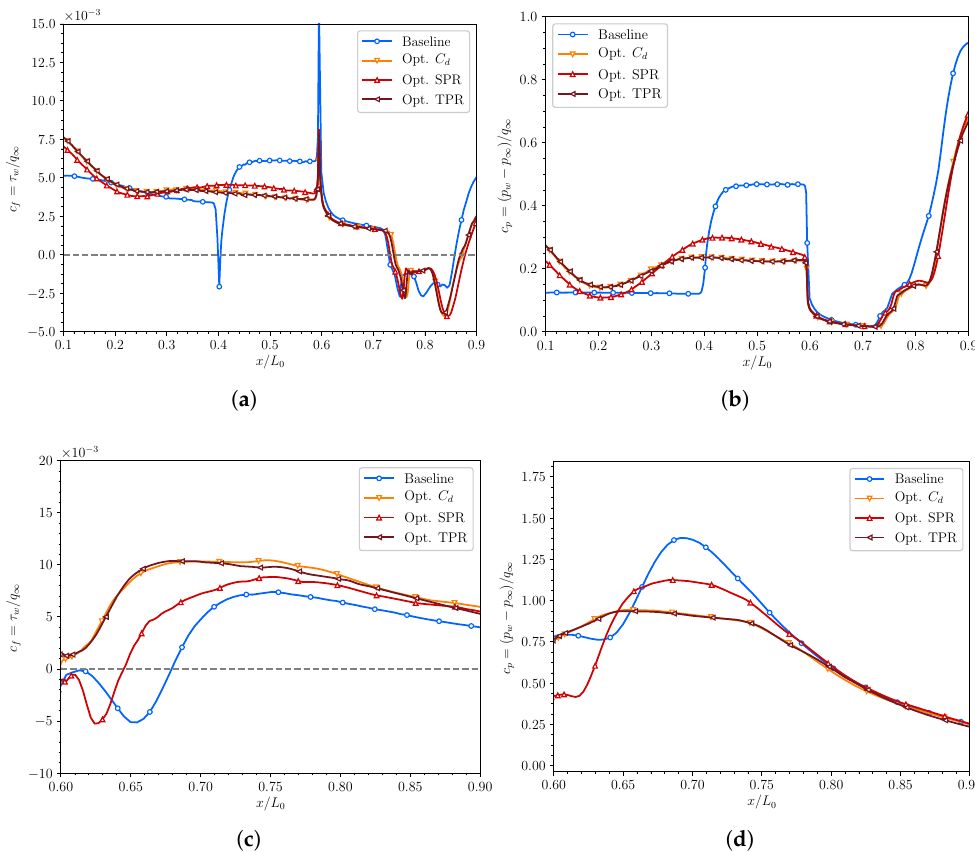
Figure 16. Comparison between the baseline and the optimal f 1 / f 2 / f 3 friction and pressure co- efficient trends along the bottom and the top surfaces. ( a ) Friction coefficient (bottom surface); ( b ) Pressure coefficient (bottom surface); ( c ) Friction coefficient (top surface); ( d ) Pressure coefficient (top